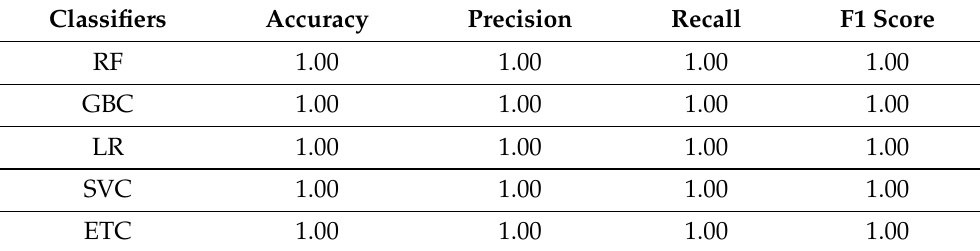
Table 7. Machine learning models results by using RF and GBM extracted features.